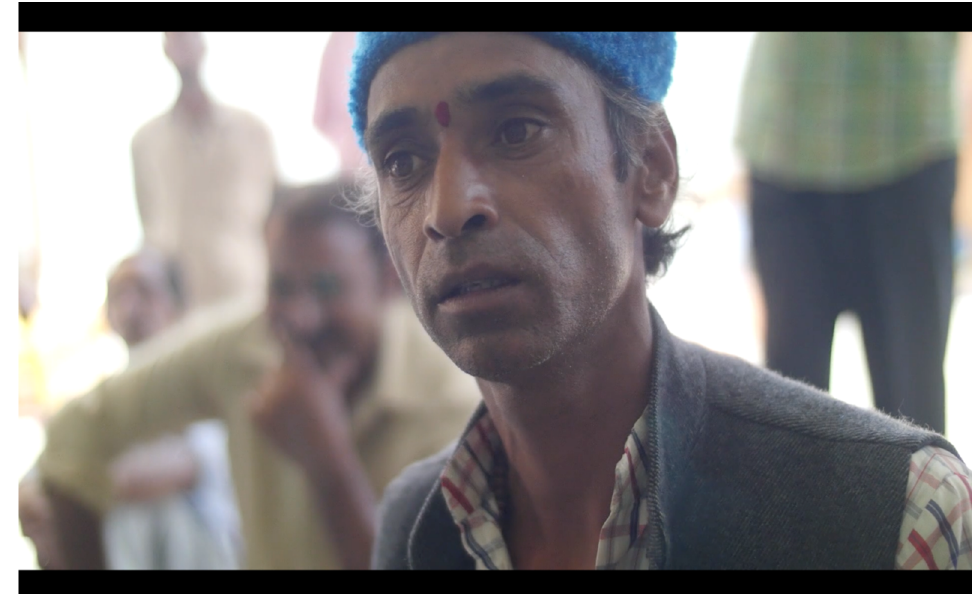
Figure 4. Medium ( gur ) Jyoti Sharma recounting the goddess’s history. Credit: Nadav Harel.